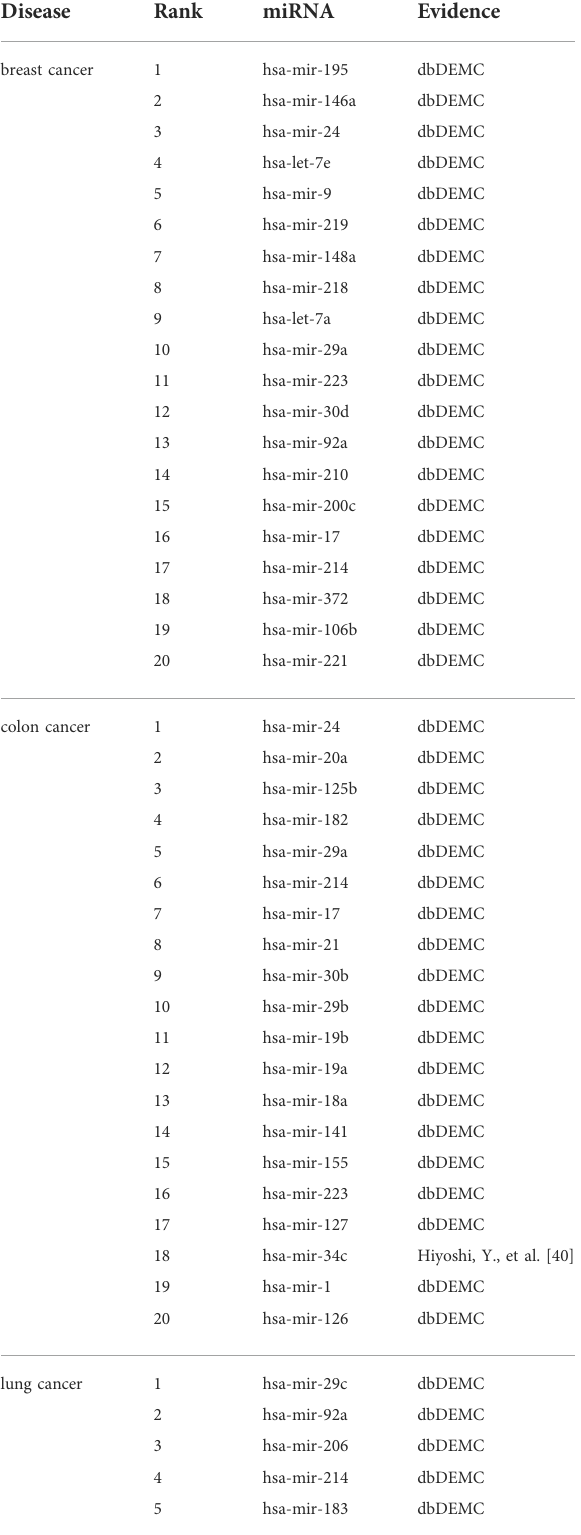
TABLE 4 The top 20 miRNAs for three cancers predicted by the CSMDA. Disease Rank